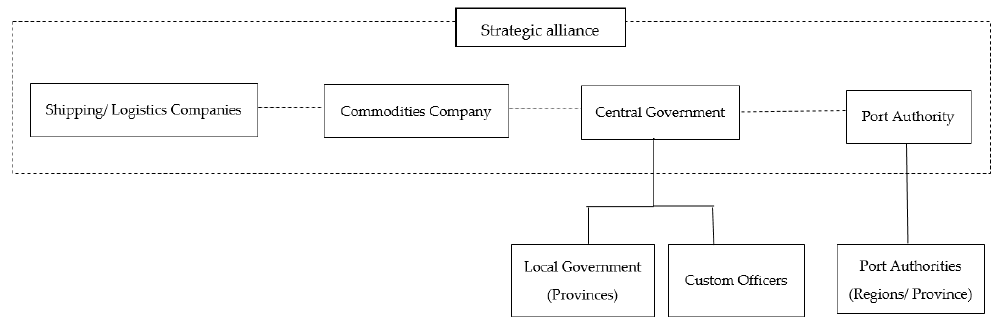
Figure 6. Strategic alliance framework.